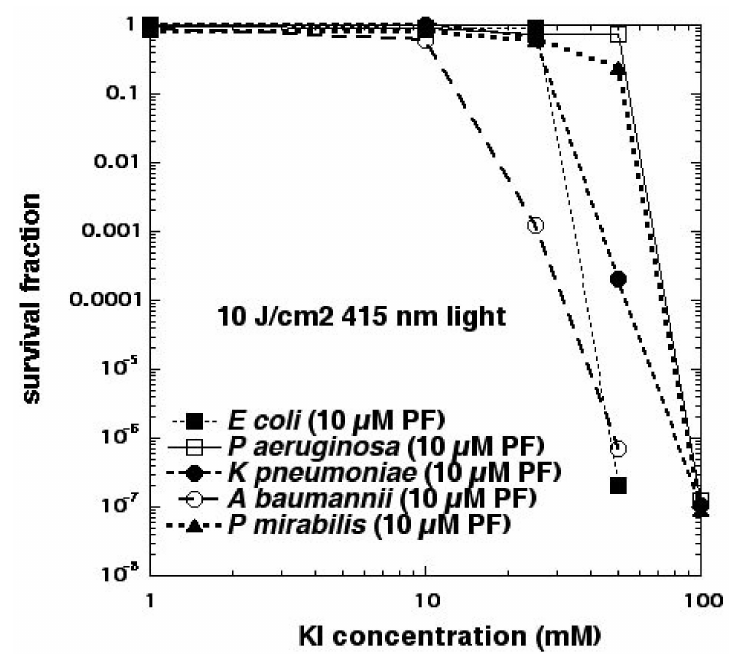
Figure 9. aPDI mediated by Photofrin kills Gram-negative bacteria in the presence of potassium iodide. Figure adapted from data contained in